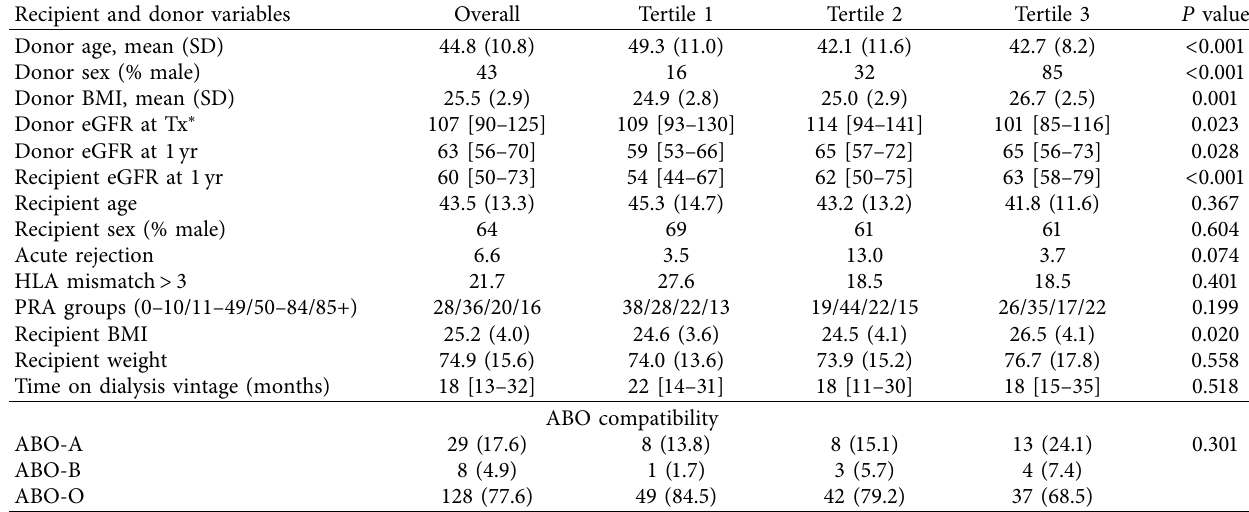
Table 1: Demographic characteristics of donors and recipients and variables.